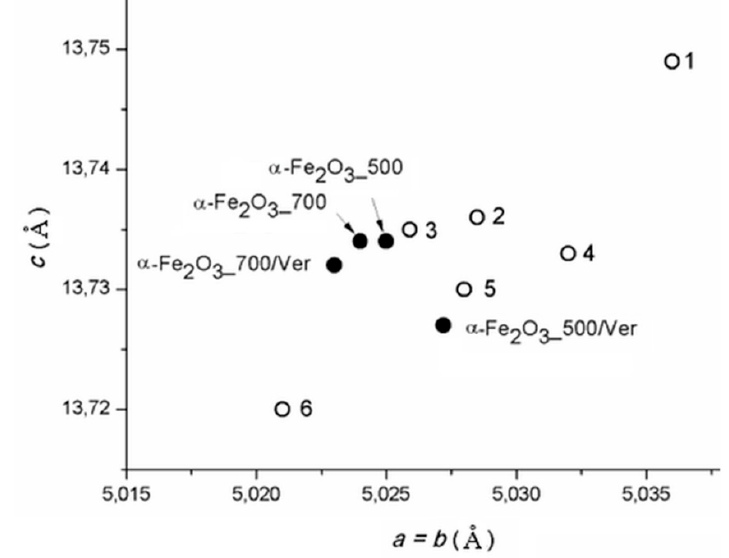
Figure 2. Lattice parameters a vs. c of α -Fe 2 O 3 calculated for studied samples and in PDF cards: No.